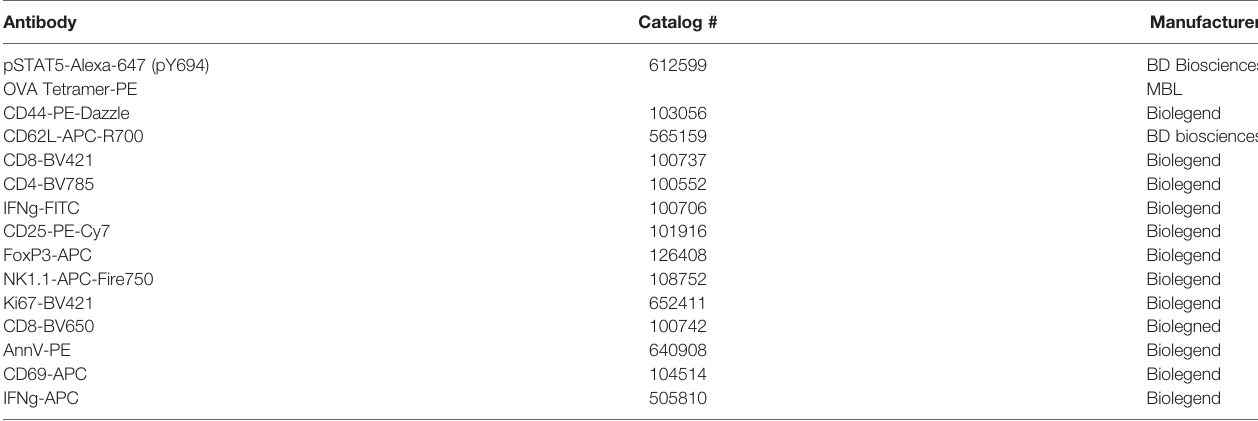
TABLE 1 | Flow antibodies.